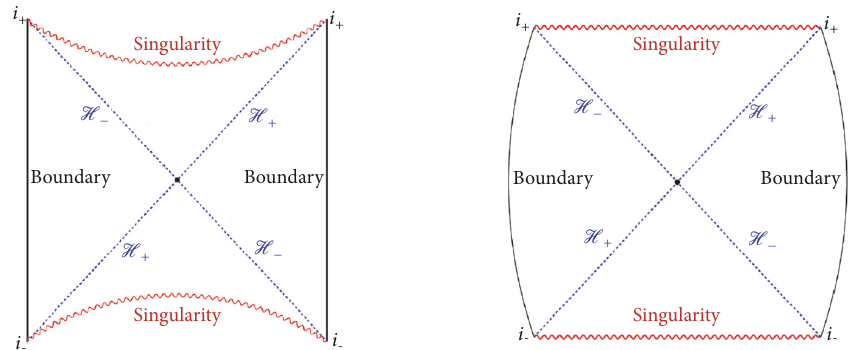
Figure 12: Penrose diagram corresponding to an OSM embedded in a purely AdS 3 (a) and a purely AdS 4 (b) background. The black dot at the centre corresponds to the bifurcation surface. In both these cases, there is a singularity denoted by the red curvy